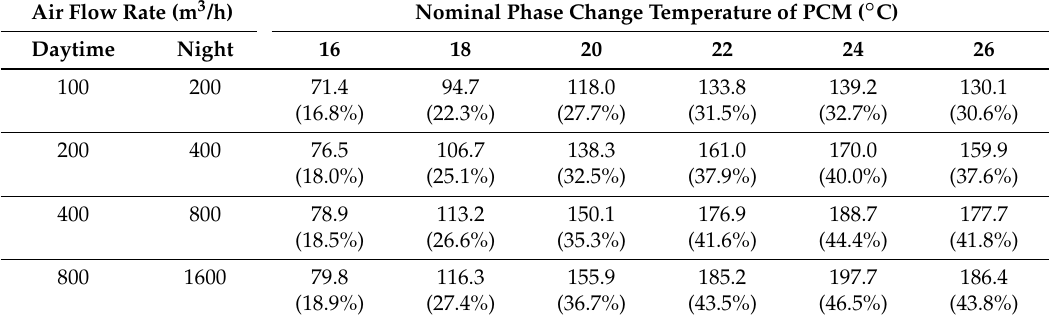
Table 6. Energy saving potential (ESP) in kWh for Madrid at various air flow rates for the temperature set point T outdoor > 20 ◦ C. The percentage in brackets is the utilization rate of the heat of fusion